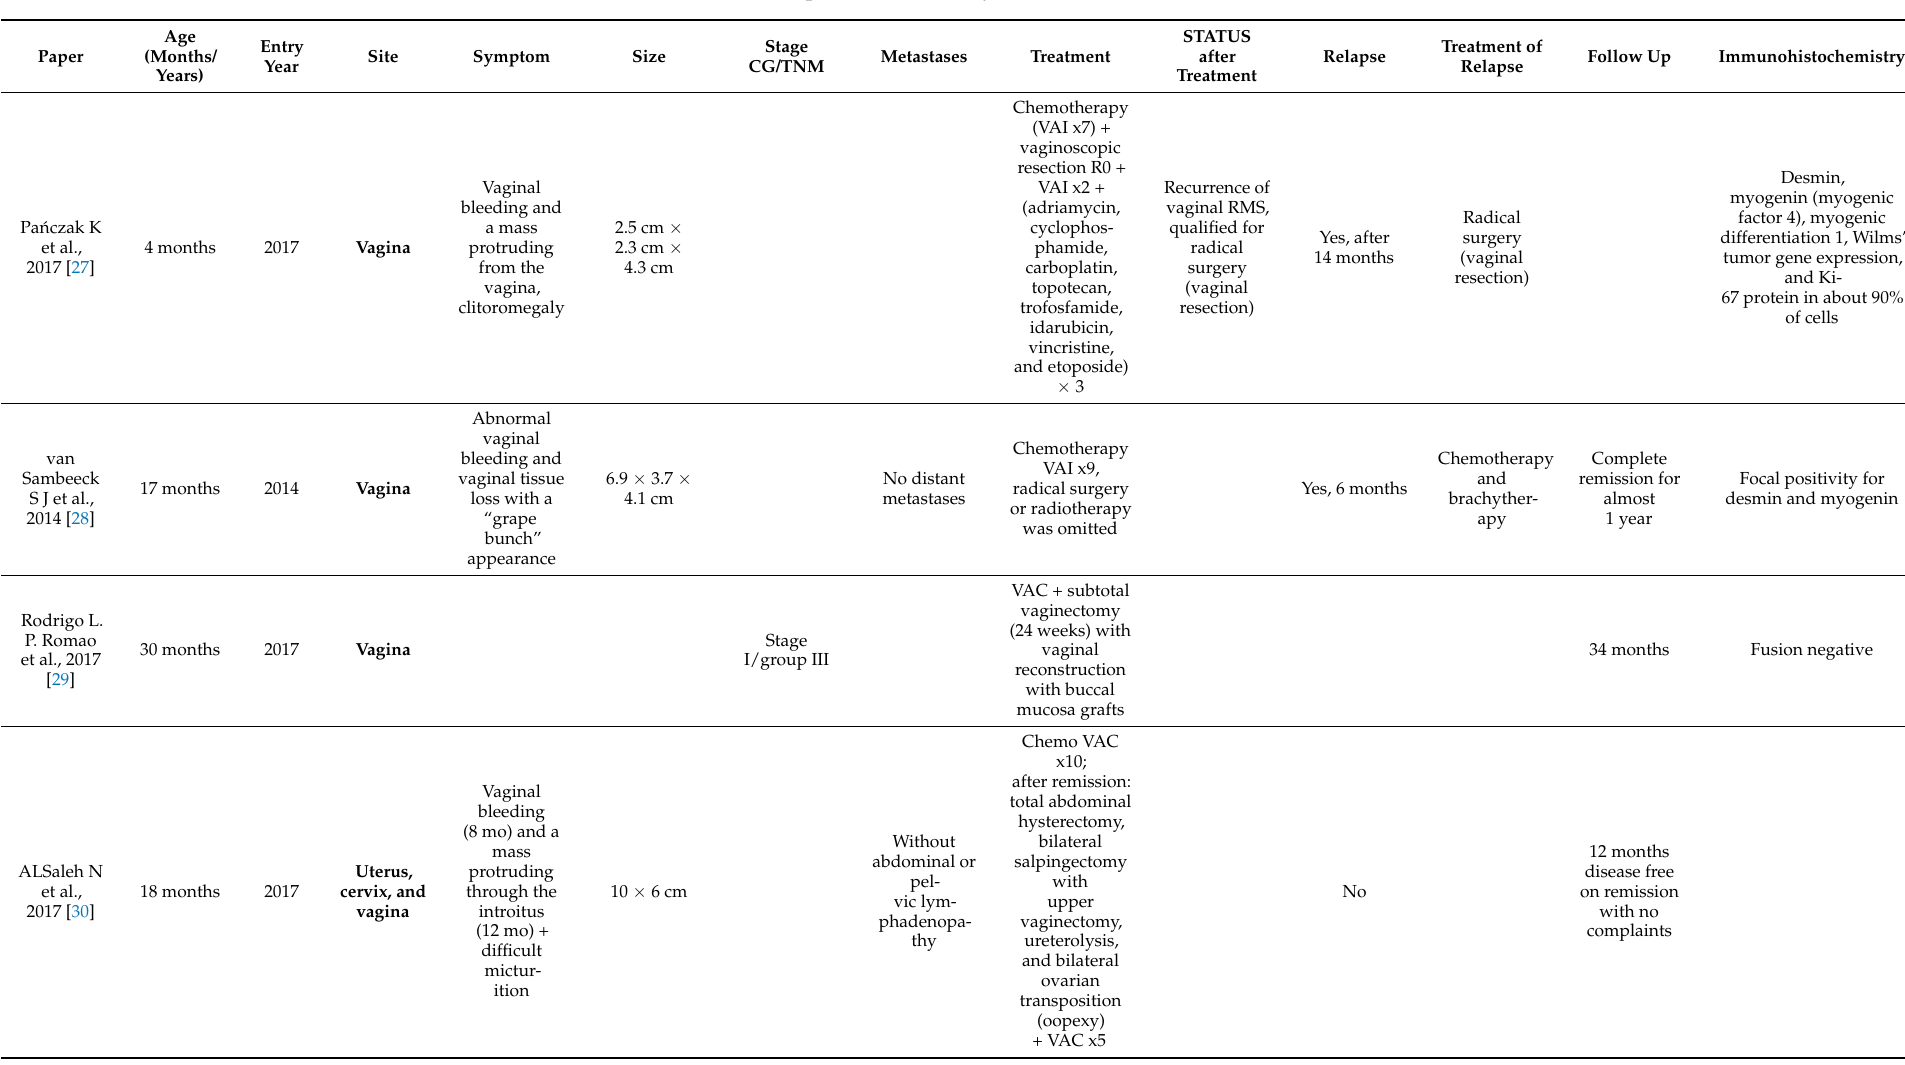
Table 1. Characteristics and treatment of female patients with botryoid sarcoma